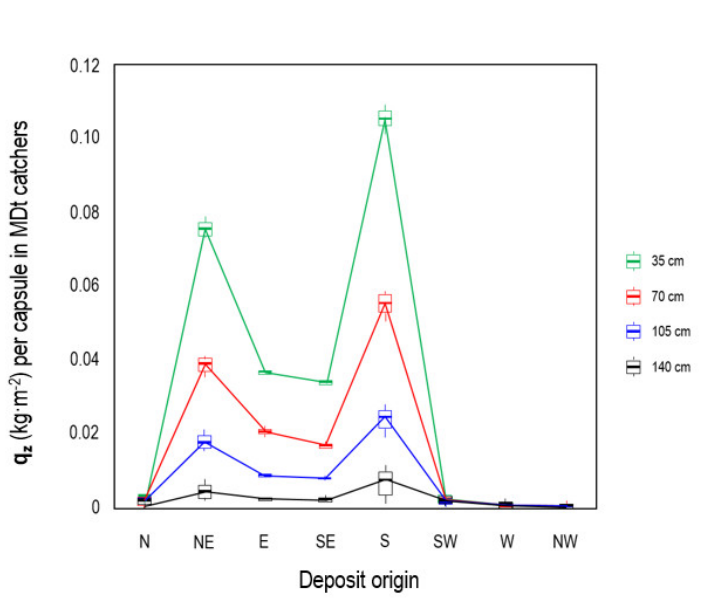
Figure 5. Averaged sediment flux (q z ) by height and direction of provenance.